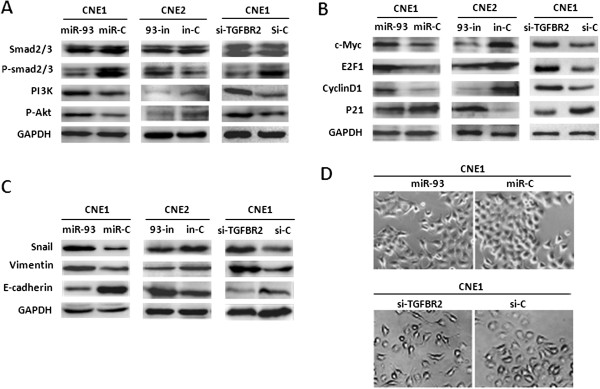
Regulation of Smad-dependent TGF-β signaling, PI3K/Akt signaling, cell cycle progression and EMT by miR-93-mediated TGFβR2 inactivation in NPC cells. (A) Western blotting analyses of Smad2/3 and its phosphorylation as well as PI3K and p-Akt in the indicated cell groups. (B) Western blotting analyses of C-myc, E2F1, cyclin D1, CDK4 and p21 in the indicated cell groups. (C) Western blotting analyses of Snail, E-cadherin, and Vimentin in the indicated cell groups. (D) The morphological observations of the indicated cell lines. CNE1 cells were transfected with miR-93 mimic/siRNA-TGFβR2 and miRNA/siRNA control for 96 hours and analyzed under phase contrast microscopy (400×).